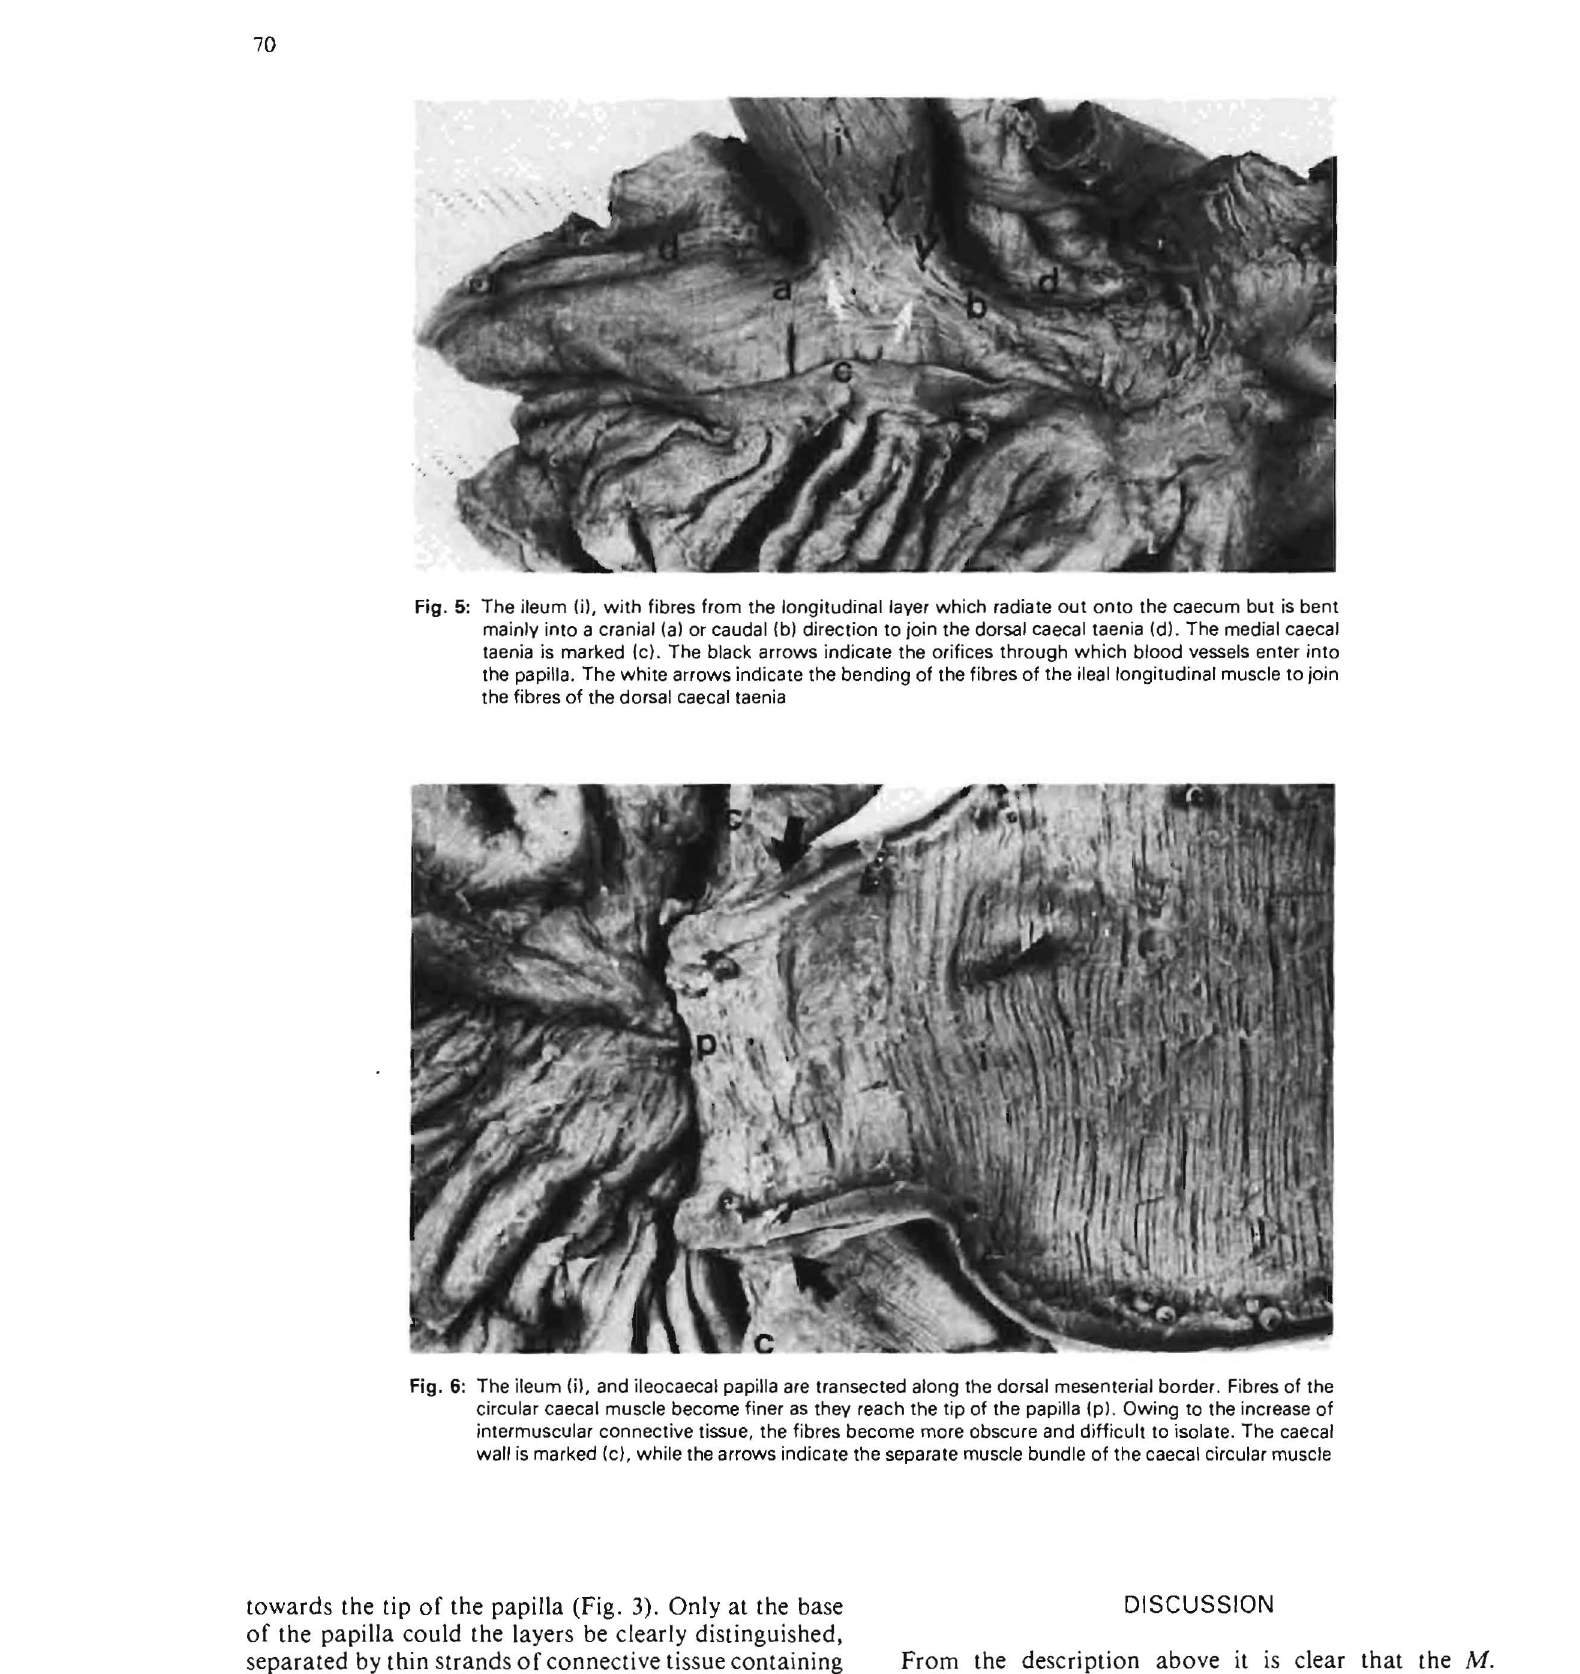
Fig. 6: The ileum (i), and ileocaecal papilla are transected along the dorsal mesenterial border. Fibres of the circular caecal muscle become finer as they reach the tip of the papilla (p). Owing to the increase of intermuscular connective tissue, the fibres become more obscure and diHicult to isolate. The caecal wall is marked (c), while the arrows indicate the separate muscle bundle of the caecal circular